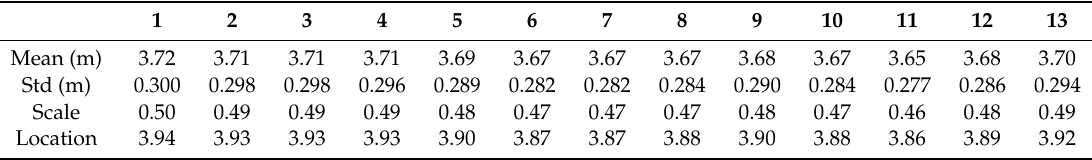
Table 4. Mean, standard division, scale, and location parameters for the 13 measuring